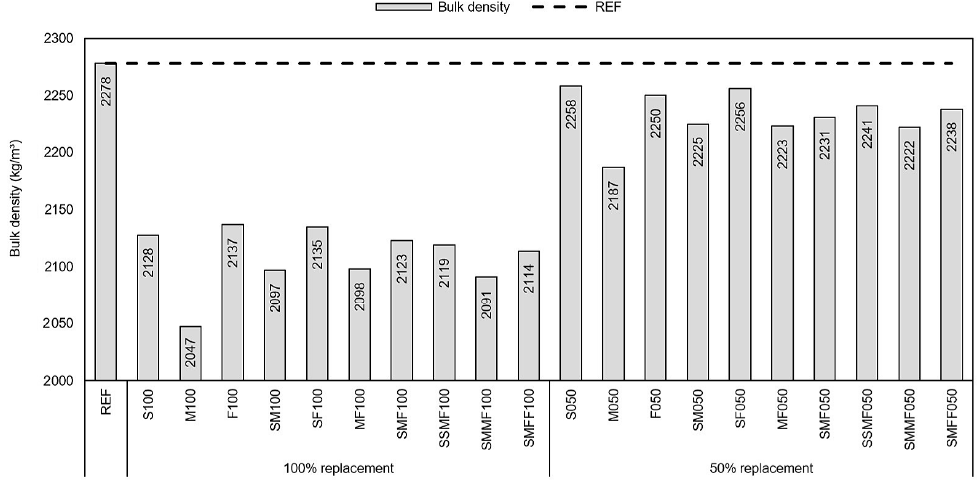
Figure A7. Bulk density in the fresh state.